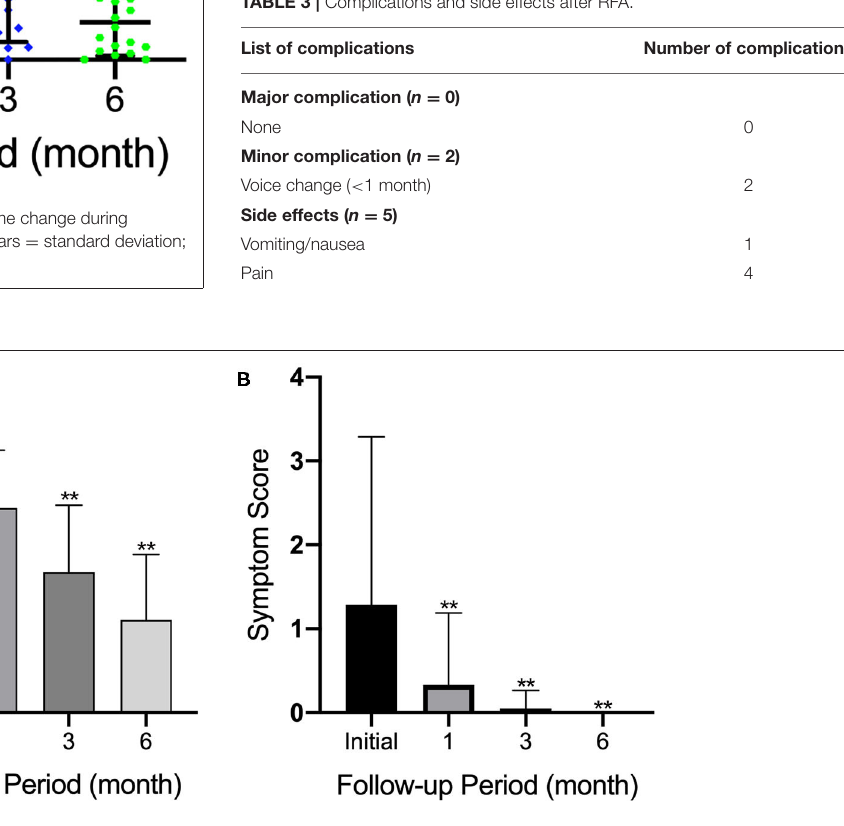
FIGURE 4 | Graphs show (A) cosmetic and (B) symptom scores at enrollment and at 1, 3, and 6 months after initial RF ablation. Error bars = standard deviation; * p < 0.05; ** p < 0.01.